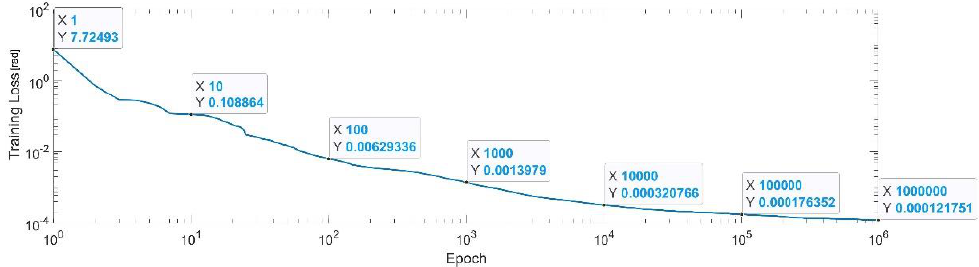
Figure 23. Convergence of the neural network for the first generalized coordinate 𝑞 5 (log scale).